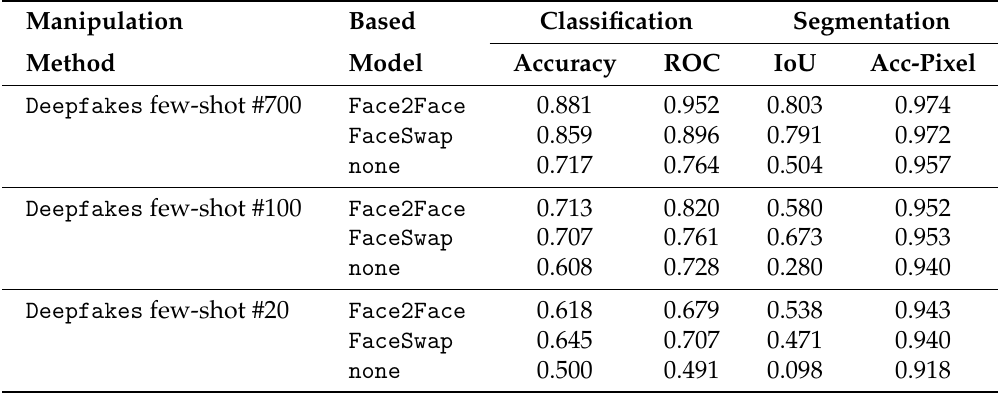
Table 3. Results for few-shot learning of detecting C23 crop images altered by the Deepfakes manipula- tion methods with difference-based models. In this table, acc-pixel stands for pixel-wise accuracy.